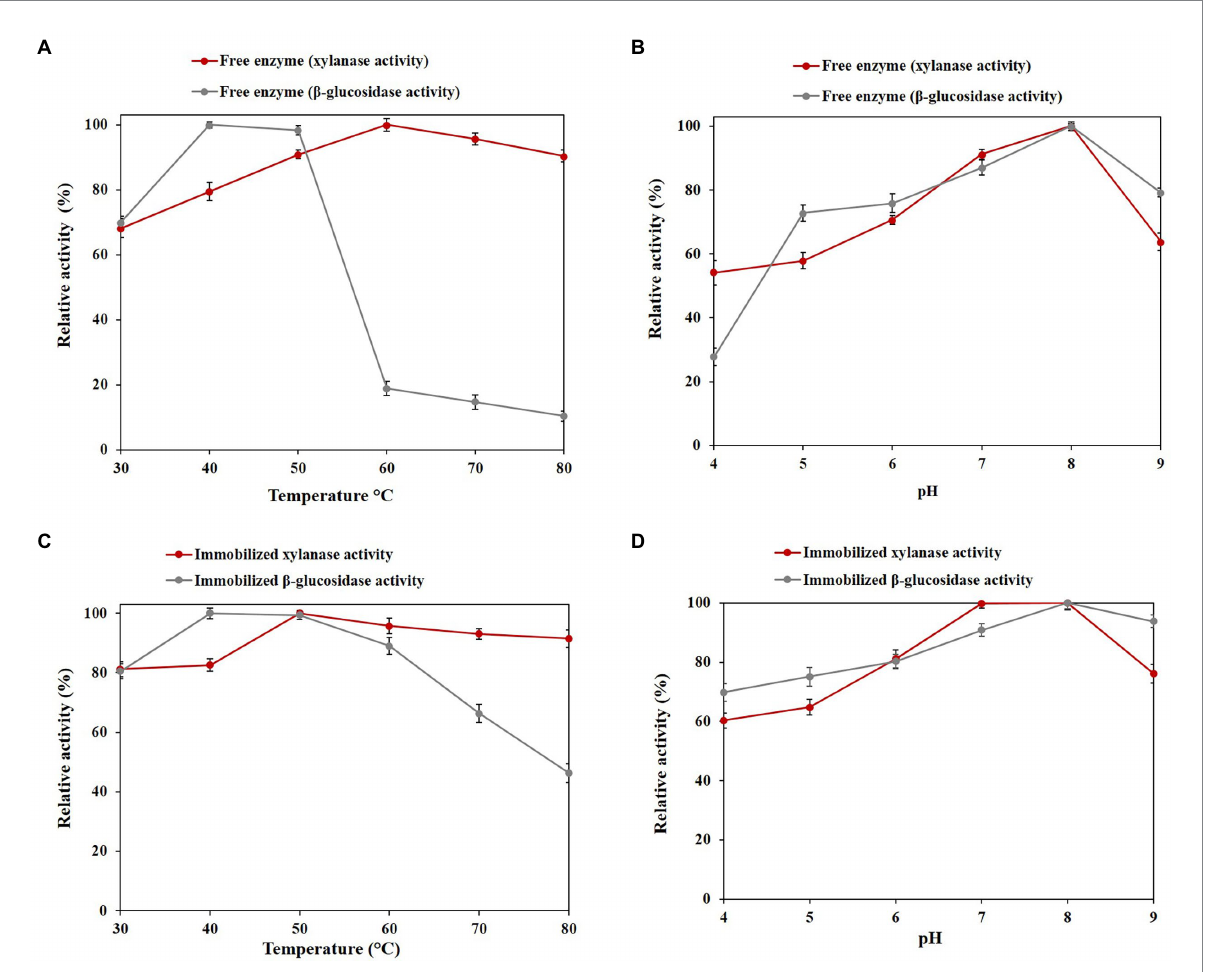
FIGURE 4 Optimal values of free and immobilized PersiBGLXyn1. (A) Effect of temperature on the xylanase and β -glucosidase activity of free enzyme at 30 to 80 ° C. (B) Effect of pH on the xylanase β -glucosidase activity of free enzyme after at pH 4 to 9. (C) Effect of temperature on the xylanase and β -glucosidase activity of immobilized enzyme at 30 to 80 ° C. (D) Effect of pH on the xylanase and β -glucosidase activity of immobilized enzyme at pH 4 to